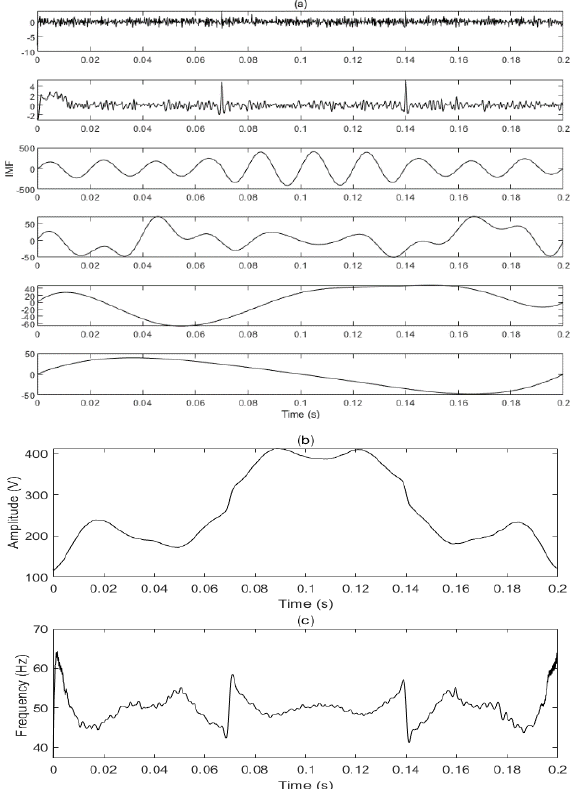
Figure 9. Voltage swell IMF components ( a ), amplitude ( b ), and frequency ( c ).